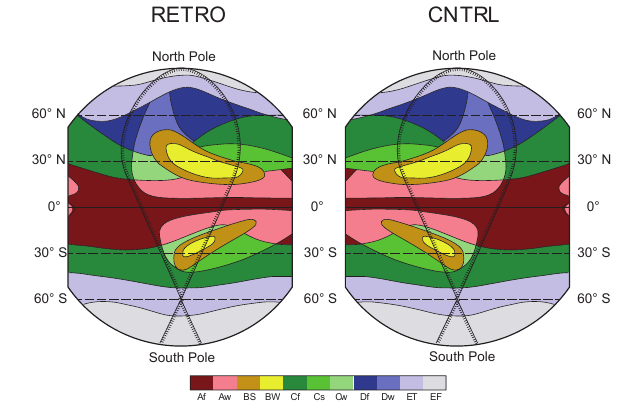
Figure 9. Classification of climate zones for an idealized continent, the Klimarübe , following Köppen (1923). First letters in the leg-